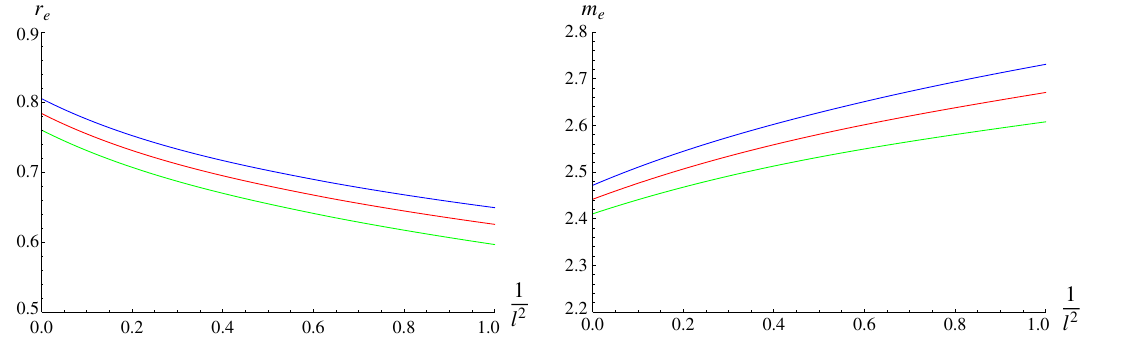
, under the different values of k , l 2